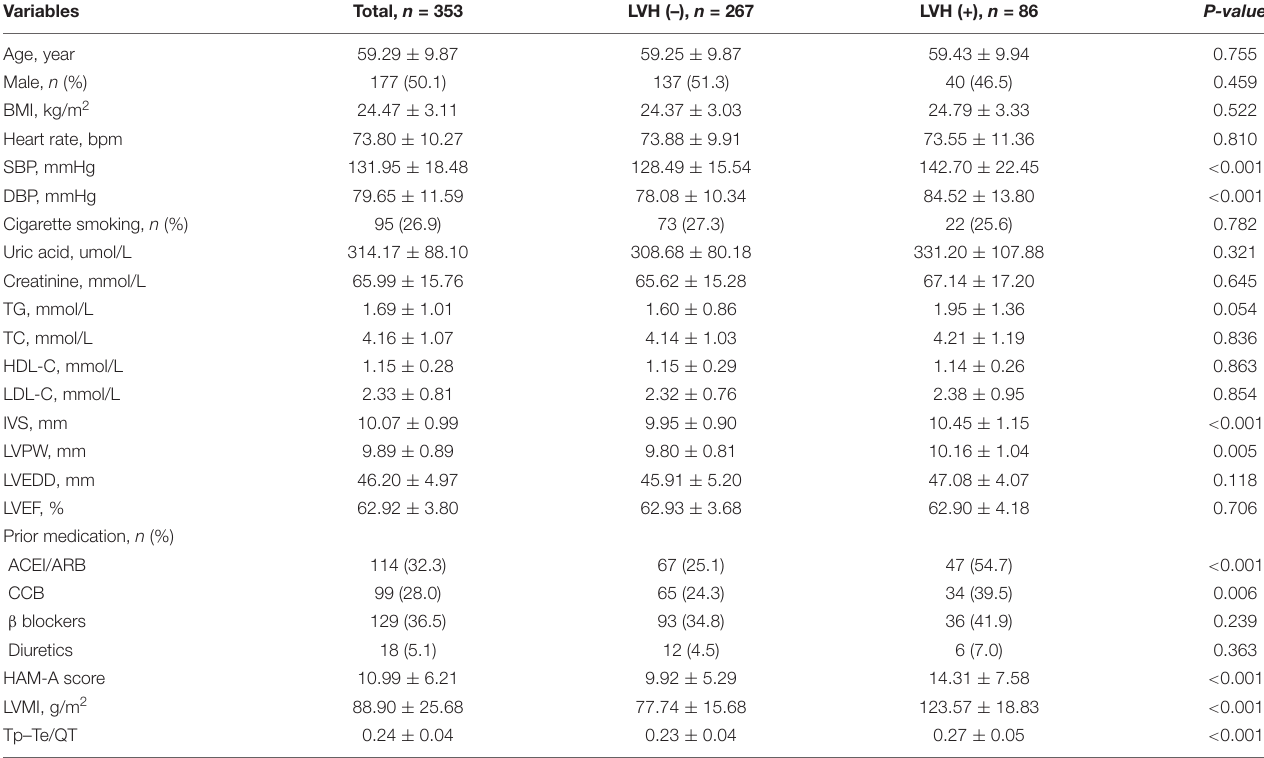
TABLE 1 | Baseline clinical characteristics of the patients with